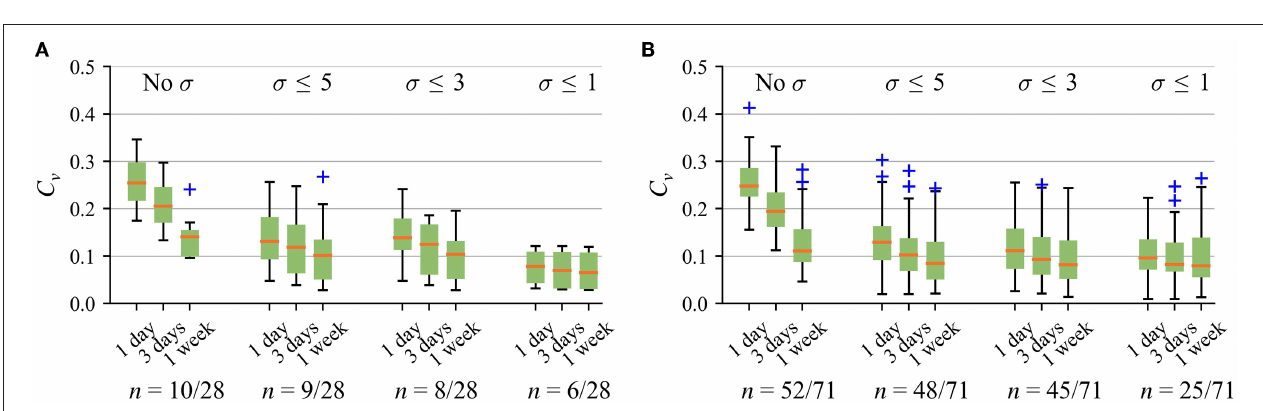
FIGURE 4 | Within-subject reproducibility for the 6MWT with different cadence variation σ in (A) patients with CVD and (B) healthy subjects below and over 40-years-old. Only those subjects who meet the criteria of at least three walk tests detected are included for C v estimation. In this figure, “No σ ” means that no restriction to maximal cadence variation is